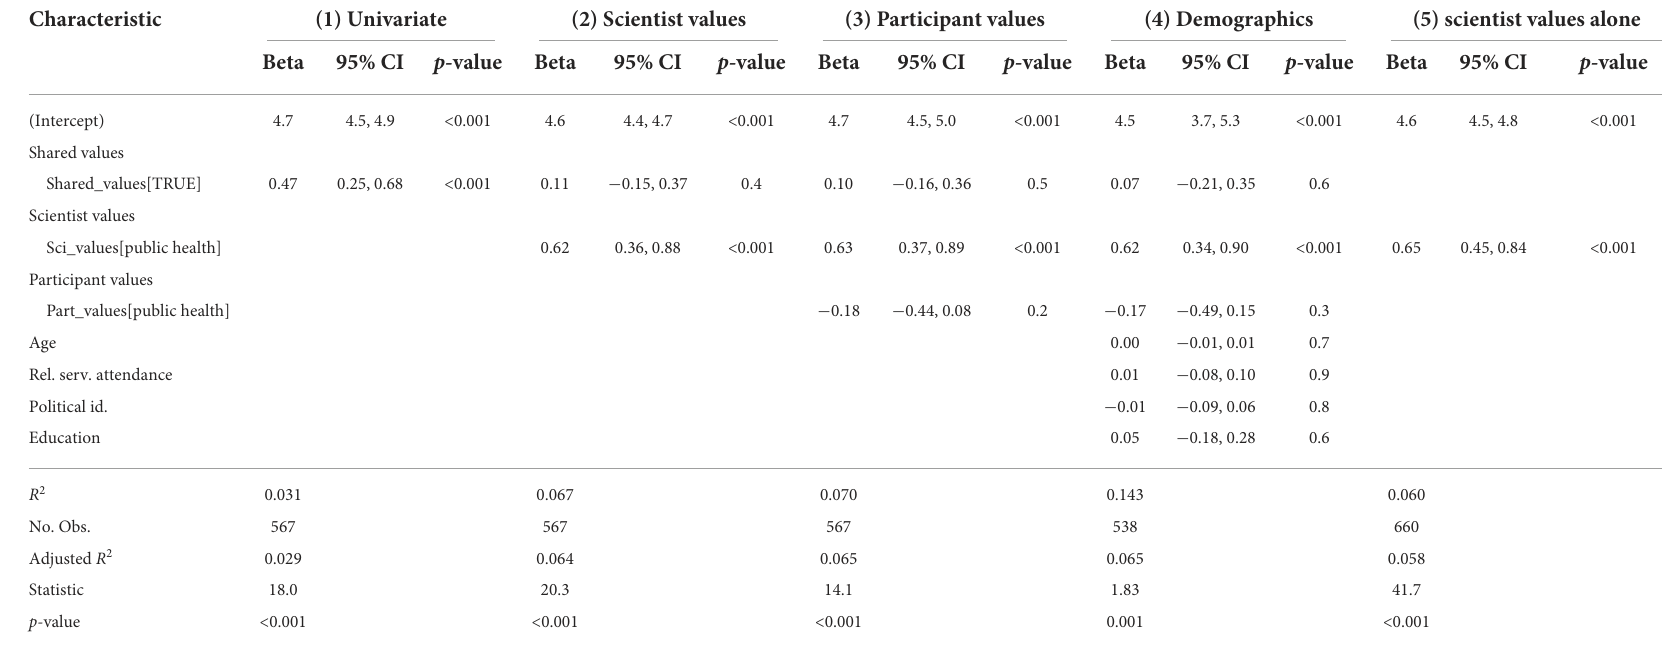
TABLE 3 Sequential regression analysis of hypothesis H4 shared values/scientist values effects.